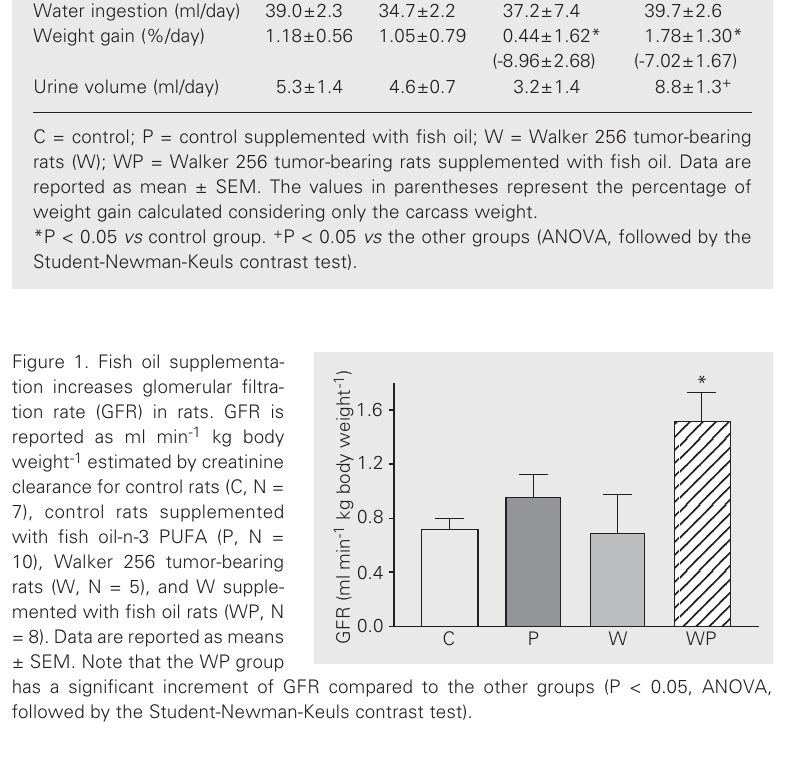
Figure 1. Fish oil supplementa- tion increases glomerular filtra- tion rate (GFR) in rats. GFR is reported as ml min -1 kg body weight -1 estimated by creatinine clearance for control rats (C, N = 7), control rats supplemented with fish oil-n-3 PUFA (P, N = 10), Walker 256 tumor-bearing rats (W, N = 5), and W supple- mented with fish oil rats (WP, N = 8). Data are reported as means ± SEM. Note that the WP group has a significant increment of GFR compared to the other groups (P < 0.05, ANOVA, followed by the Student-Newman-Keuls contrast